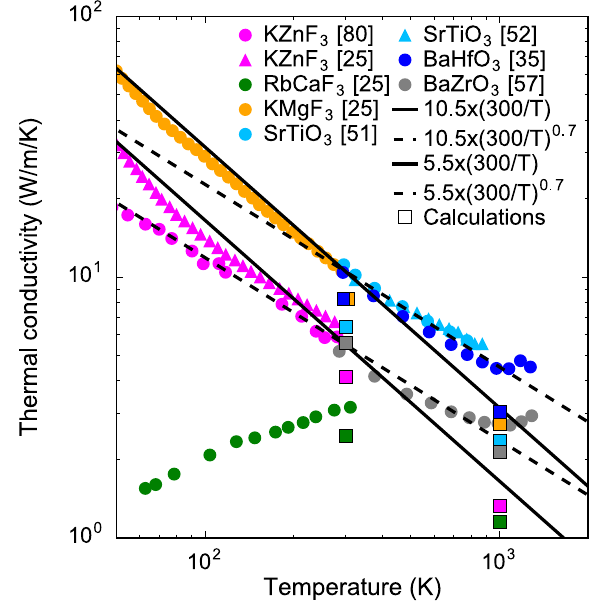
FIG. 3. A comparison between total thermal conductivities from Refs. [25,35,51,52,57,80], high-throughput calculations of the lattice thermal conductivity at 300 and 1000 K, and model behaviors in κ ∝ T − 1 and κ ∝ T − 0 . 7 .